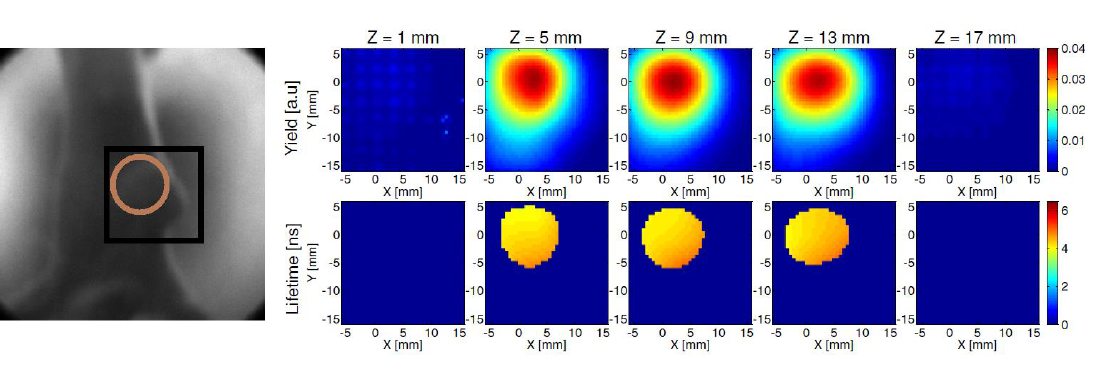
Figure 5. In vivo imaging of the HPPH-targeted tumor in mice before treatment. The mouse was immersed in the optical matching fluid (µ a = 0.4 cm −1 ; µ s ' = 10 cm −1 . Note: µ s '= µ s (1-g), which accounts for anisotropic scattering dominating in tissue. g is the anisotropy factor with a typical value of 0.9).The reconstructed fluorescence lifetime and quantum yield at different depth agreed well with reported values (The figure is from [75], with permission from